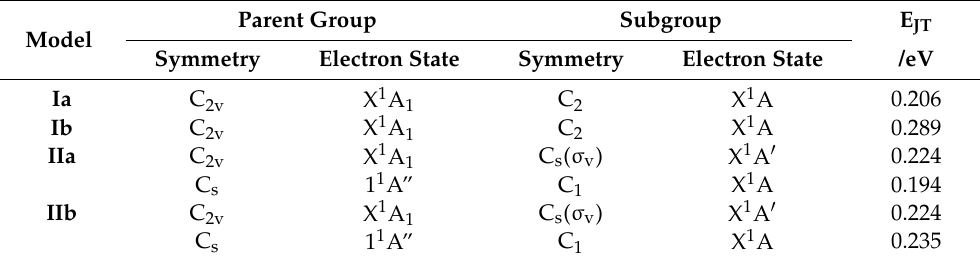
Table 3. PJT stabilization energies E JT for the relevant electron states of the stable optimized structures of JT subgroups related to the ones of their parent groups and electron states (the preserved σ v mirror plane is coincident with the curcumin molecular